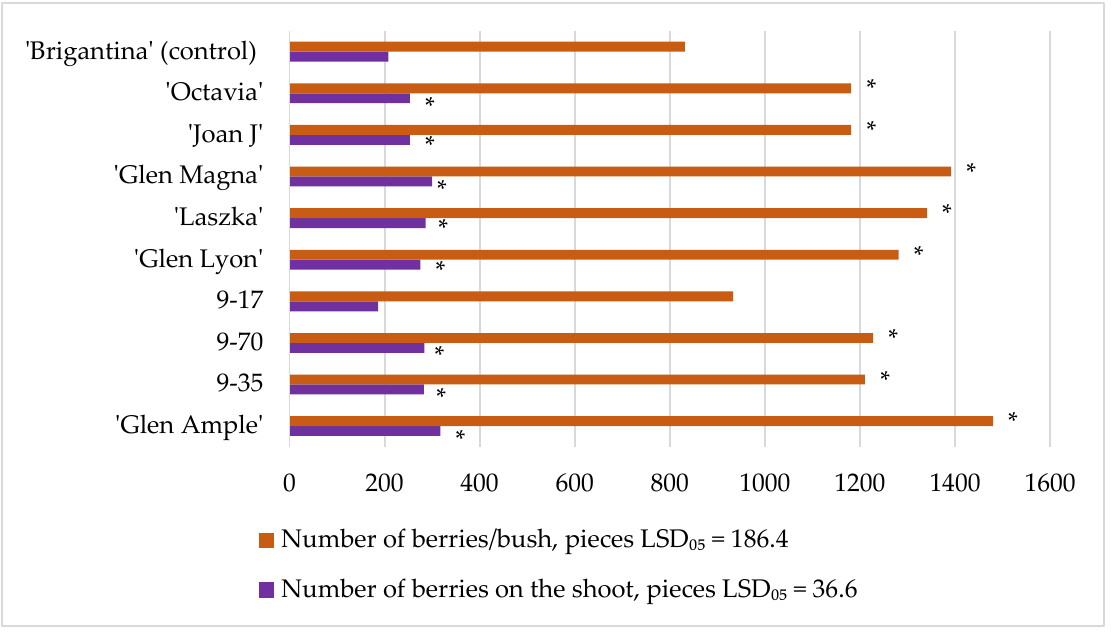
Figure 5. Average amount of raspberry berries per shoot and per bush, pieces. (2019–2021). *—significant differences at the 5% significance level.